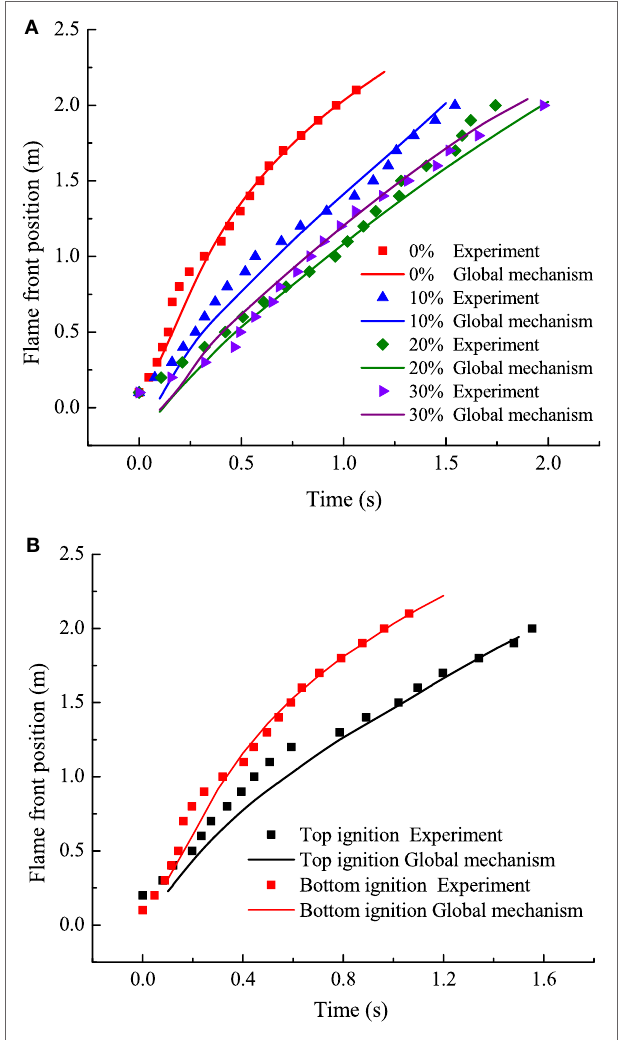
FIGURE 4 | Comparison between numerical and experimental results: (A) effect of initial steam concentration; (B) effect of ignition